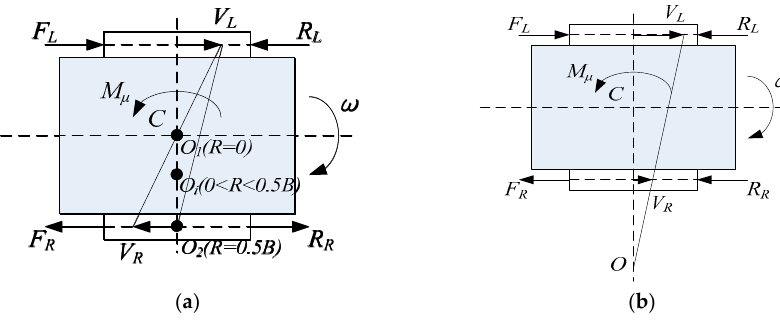
Figure 1. Force analysis: ( a ) R ≤ 0.5 B steering; ( b ) R > 0.5 B steering.